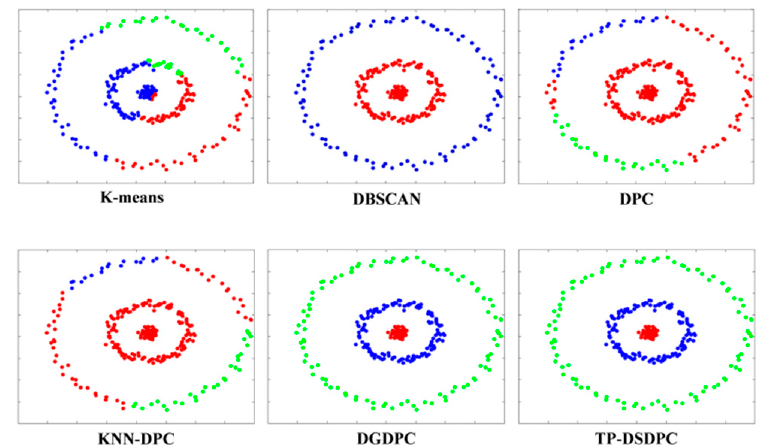
Figure 9. Clustering results on Threecircles.